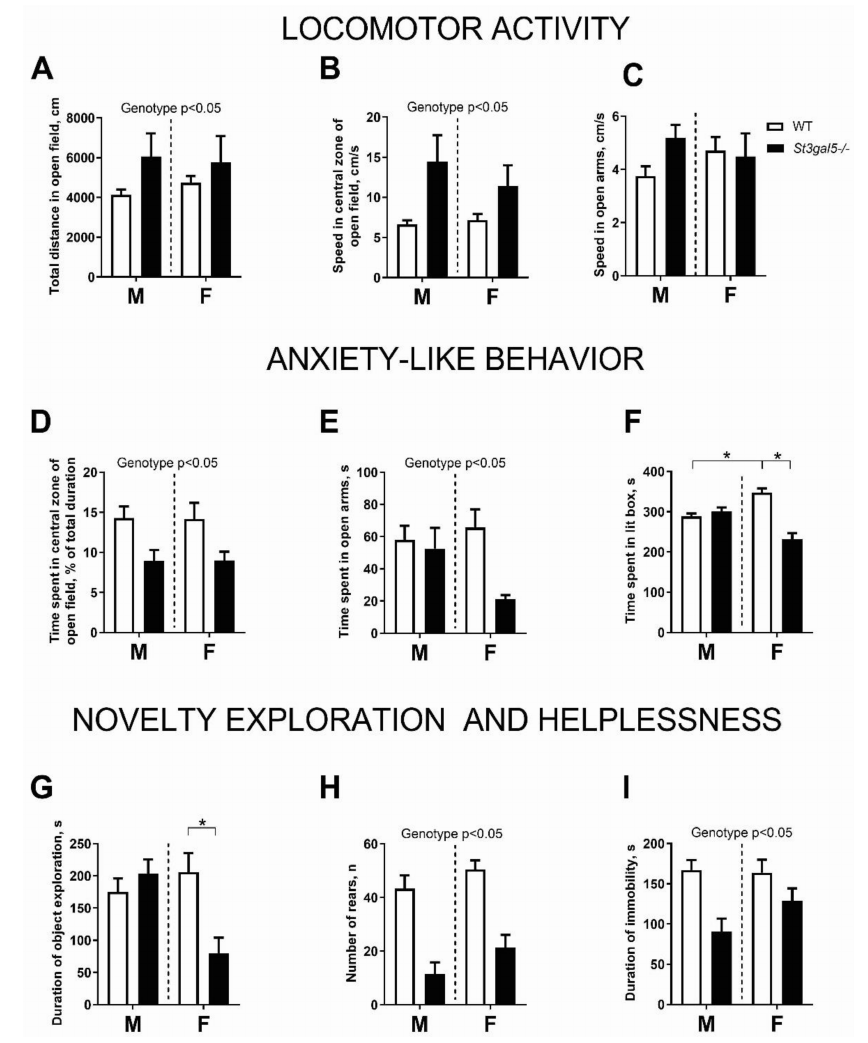
Figure 1. St3gal5 − / − mice display sex bias in behavioural signs of hyperactivity, anxiety, impulsivity and neophobia. Locomotor activity of mice was significantly affected by phenotype for ( A ) total distance moved in the open field, ( B ) mean speed in the central zone of the open field and not ( C ) speed in the open arms of the elevated plus-maze. The anxiety-like behavior of mice was significantly affected by genotype for ( D ) percent of time spent in the central zone of the open field and ( E ) time spent in the open arms of the elevated plus-maze. ( F ) Female St3gal5 − / − mice spent significantly less time in the lit compartment of the dark–light box and ( G ) exploring objects than other groups. There was a significant interaction between genotype and ( H ) the number of rears in the central compartment of three-chamber sociability test and ( I ) the duration of immobility in the tail suspension test. WT—wild-type mice, St3gal5 − / − — St3gal5 − / − mice. * p < 0.05 two-way ANOVA and Tukey’s (see text). Data are presented as Mean ±